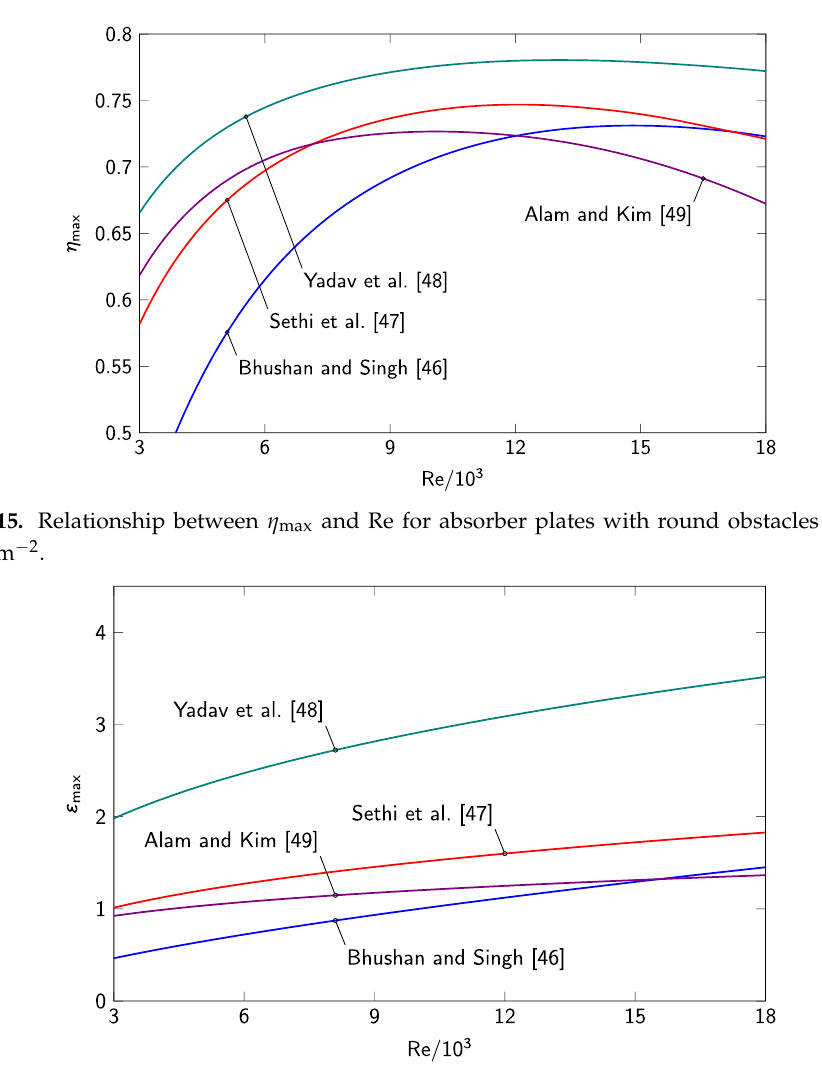
Figure 16. Relationship between ε max and Re for absorber plates with round